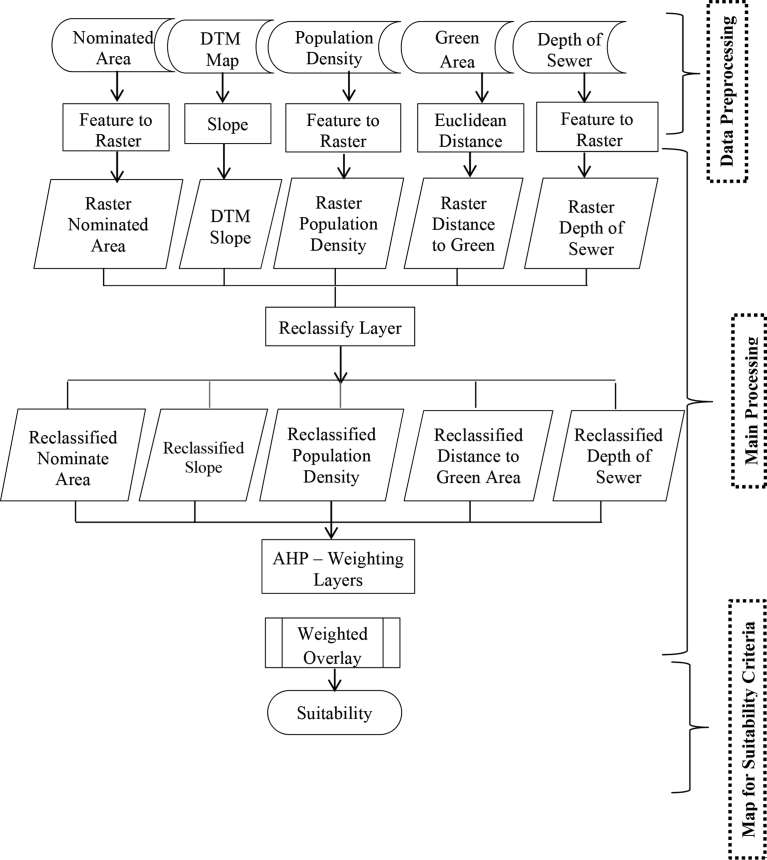
Flow chart of GIS suitability model structure.